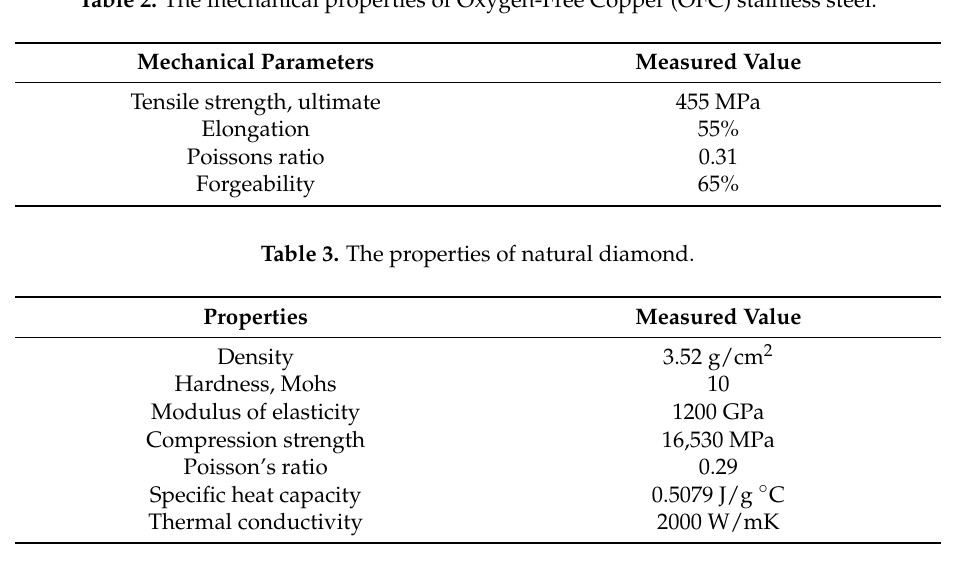
Table 2. The mechanical properties of Oxygen-Free Copper (OFC) stainless steel.